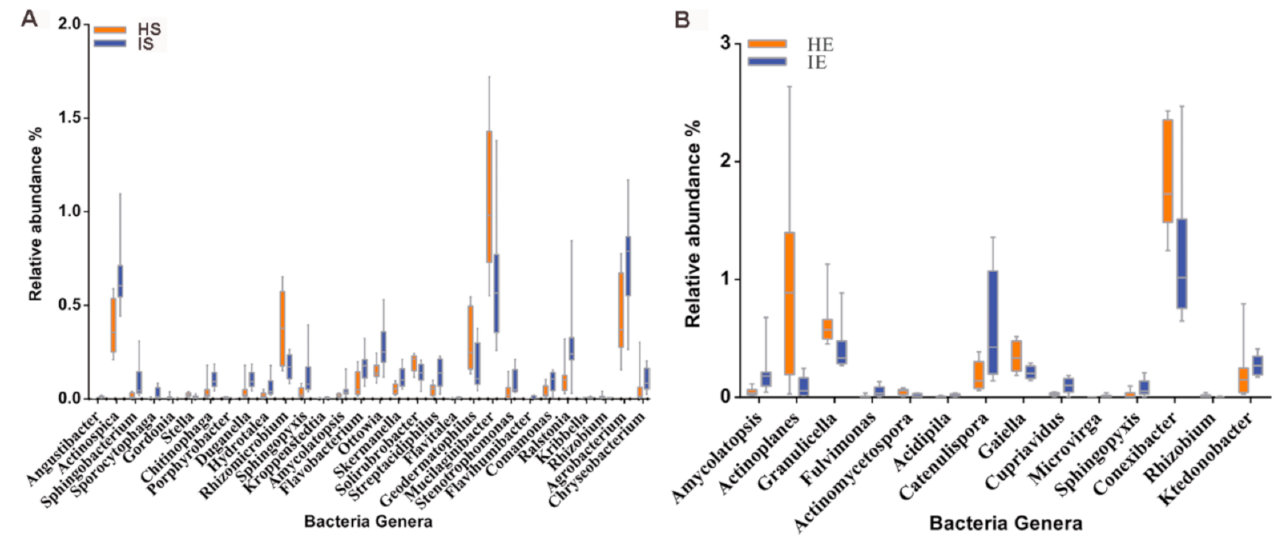
Figure 3. Composition of bacteria abundance of root endophytic compartment (IE and HE) and rhizosphere (IS and HS) between CLas-infected and healthy citrus at the genus level. ( A ). Rhizosphere difference genera. ( B ). Endogenous difference genera. The y axis represents the relative abundance of each bacteria genus. The p -values of all the genera presented in the figure were less than 0.05.